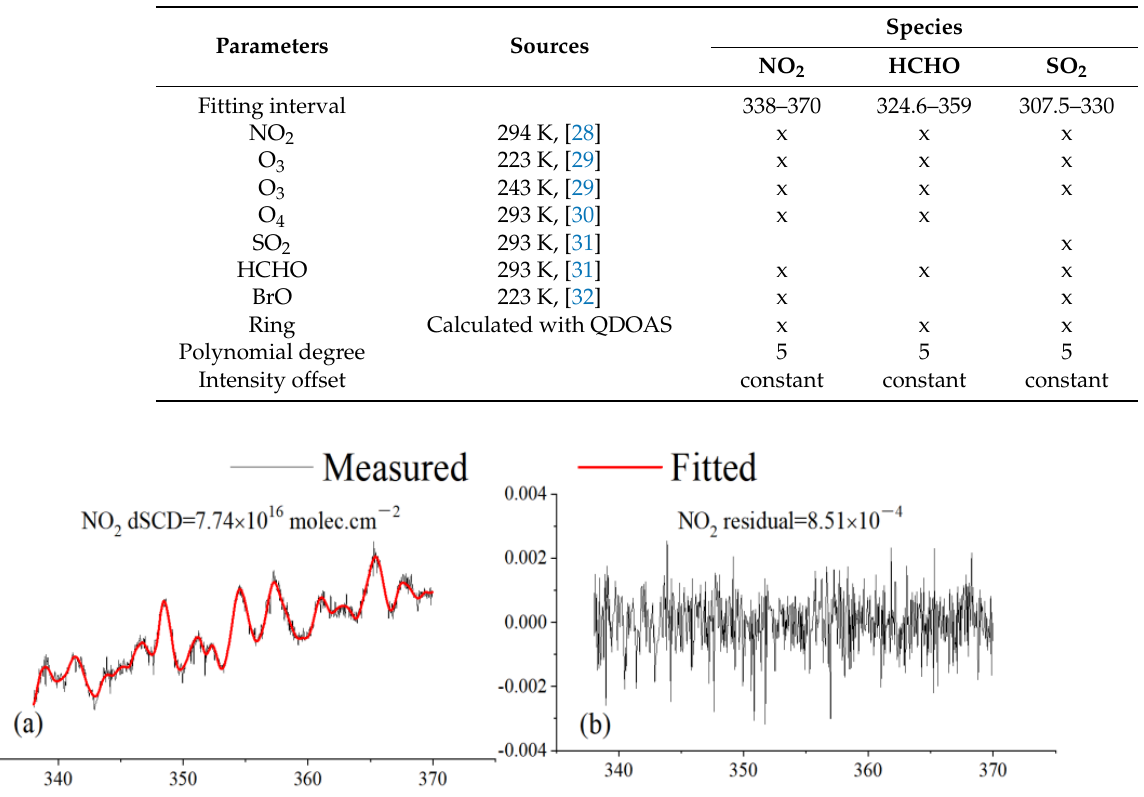
Table 1. Parameter settings used for spectral analysis using QDOAS.